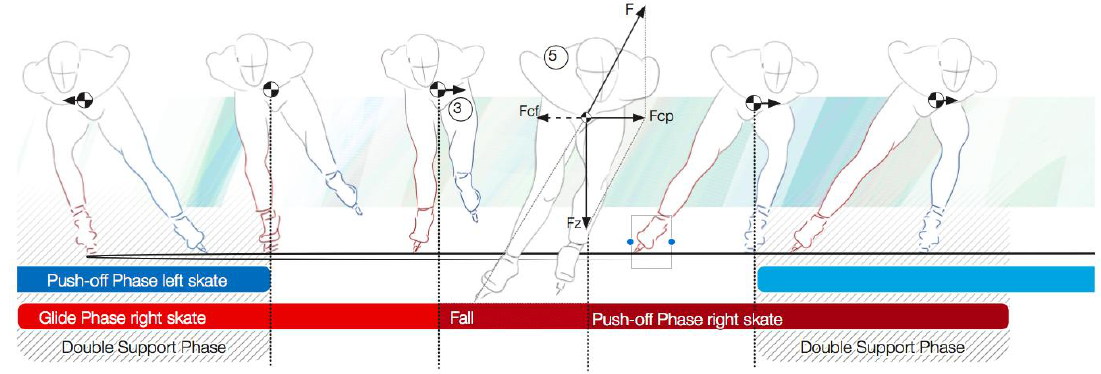
Figure 1. COM trajectory; 5 = the forces during the push-off phase; F cf is the apparent sideward force.